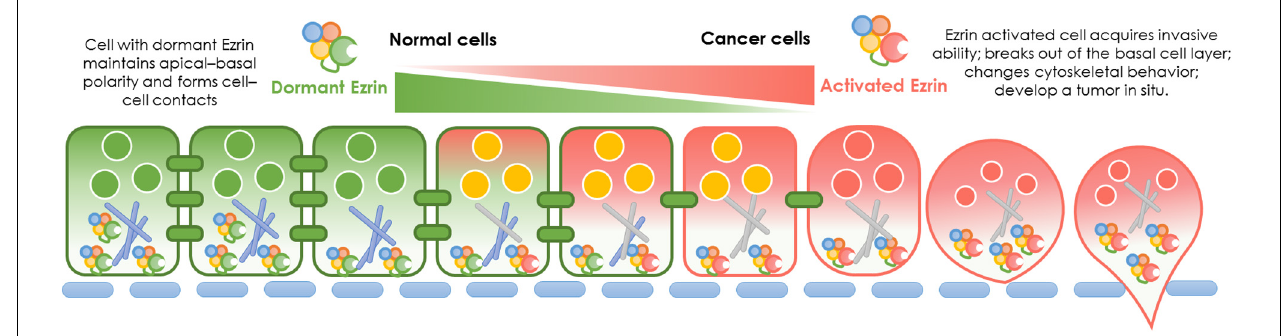
FIGURE 2 | Ezrin change between normal cells and cancer cells. Physiological function and pathological effect of Ezrin protein in normal cells versus cancerous cells. Under physiological conditions, Ezrin proteins arrange the cytoskeleton of epithelial cells, mediate signaling pathways to generate an apical–basal polarity, normal cell morphology and consistent cell–cell contacts. Under pathological conditions, Ezrin proteins are upregulated and activated to promote cancer progression and metastasis in various types of epithelial cancers (breast, lung, and prostate). The relative membrane localization of Ezrin protein is increased, cell–cell contacts disrupted and therefore facilitates the process of cancer